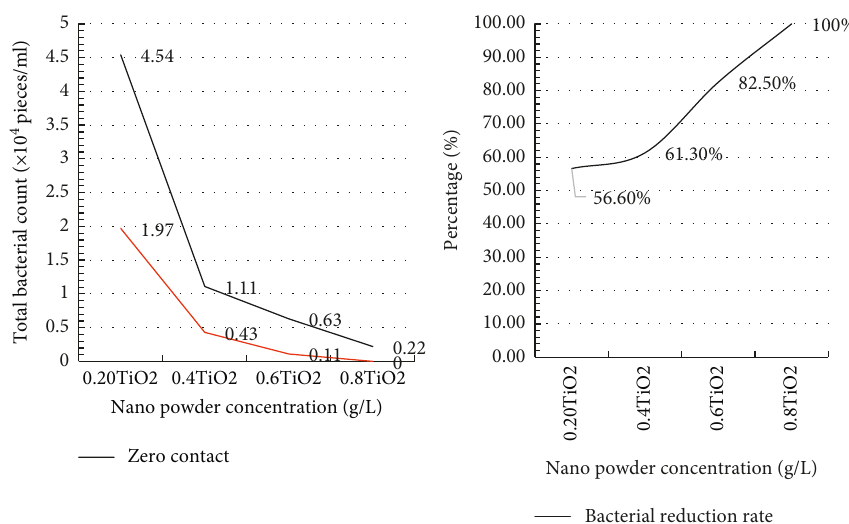
Figure 9: Evaluation of TiO2 antibacterial